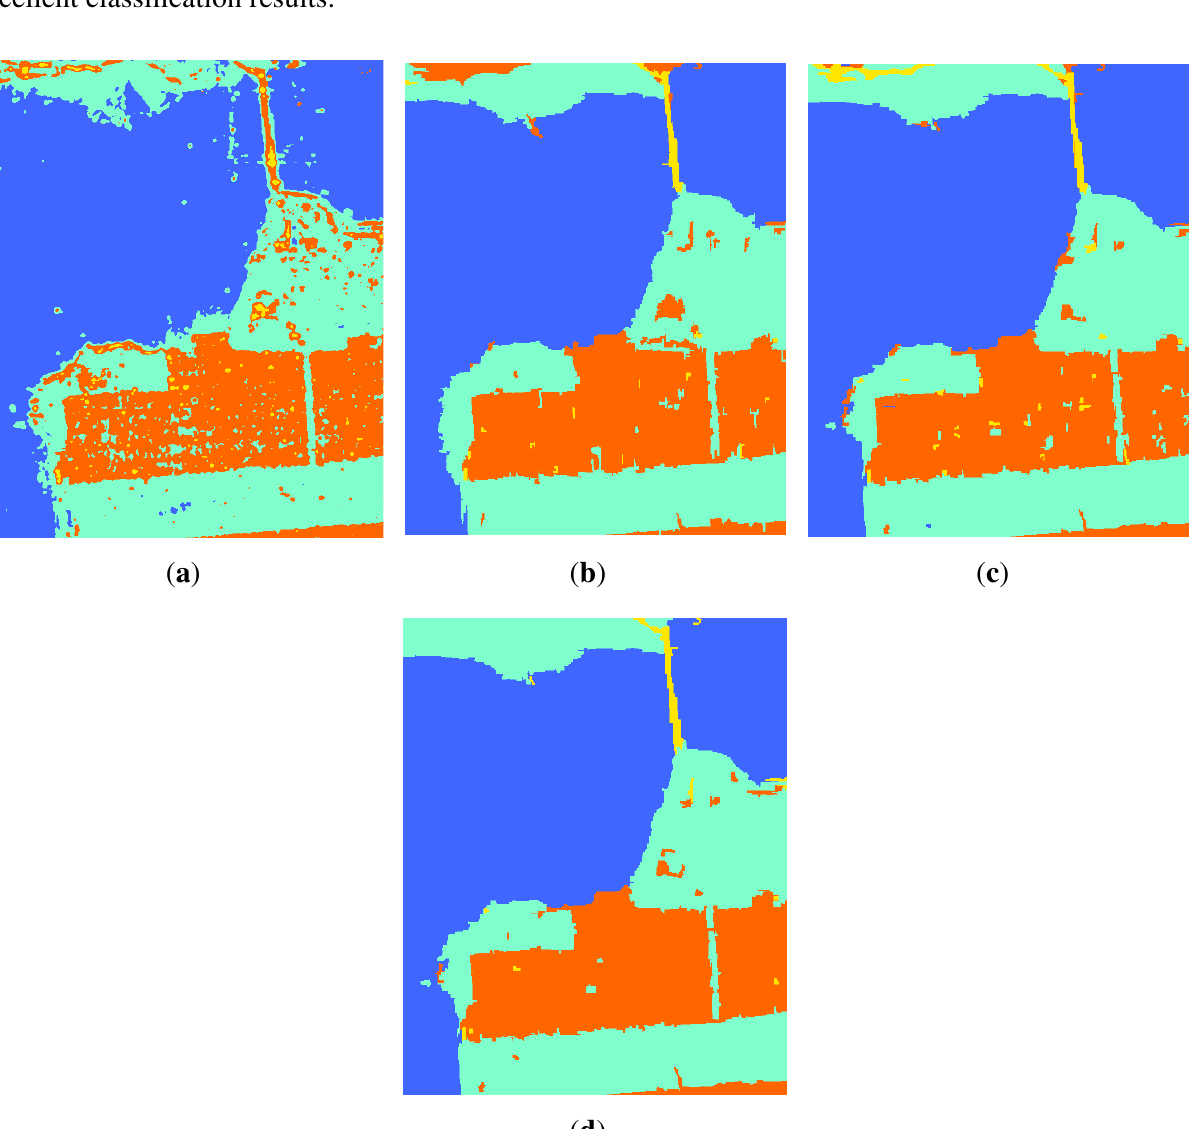
Figure 23. The classification results of the San Francisco image: ( a ) the supervised Wishart algorithm; ( b ) the original SRM classification algorithm; ( c ) the RHLBP operator introduced SRM classification algorithm; ( d ) our proposed